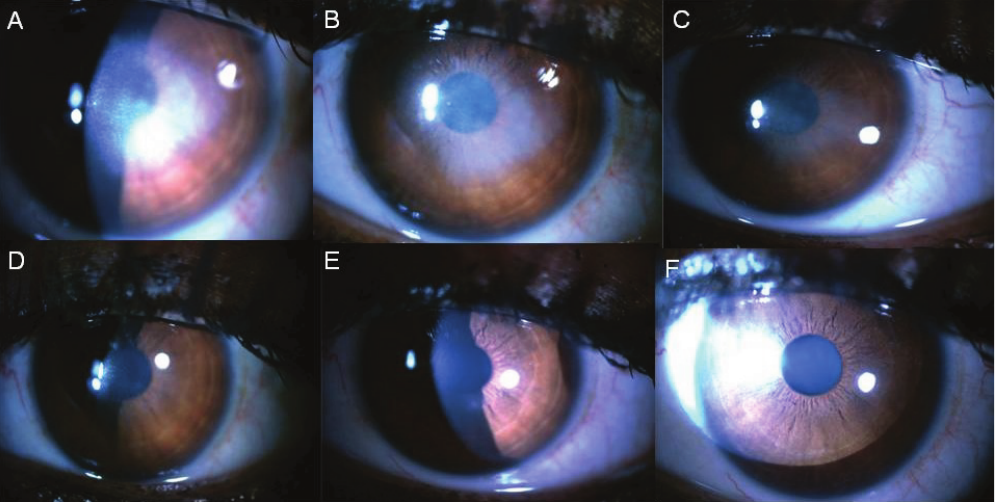
Figure 4. The significant decrease in corneal haziness and edema scores after addition of topical tacrolimus eye drops 0.05% at baseline (A), and after 3 days (B), 1 week (C), 2 weeks (D), 3 weeks (E), and 4 weeks (F).